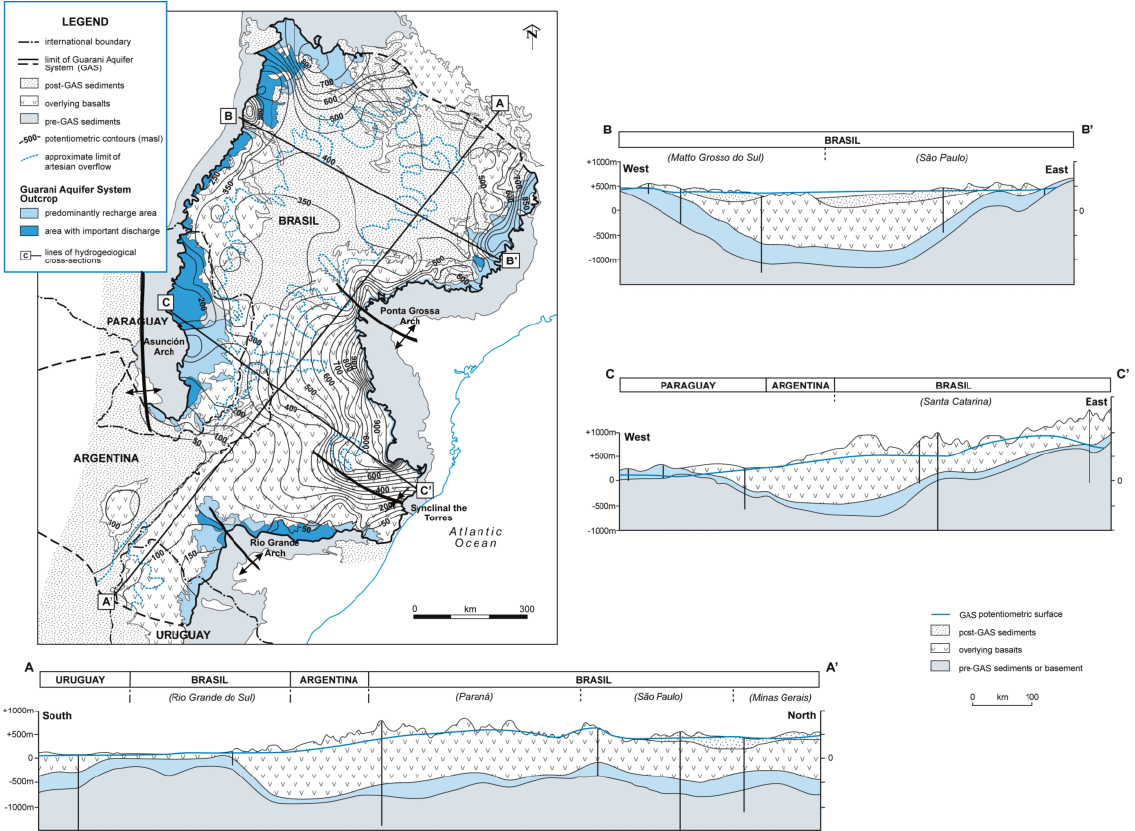
Fig. 2. Simplified geology showing pre-GAS and post-GAS sediments, GAS outcropping areas and potentiometric lines; (A) , (B) , and (C) : longitudinal and transverse geologic profiles (reproduced with permission from Foster et al., 2009).